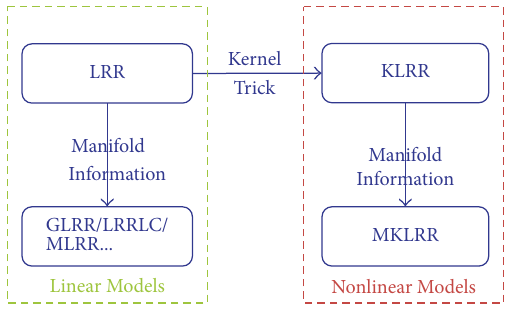
Figure 1: Connections between several LRR